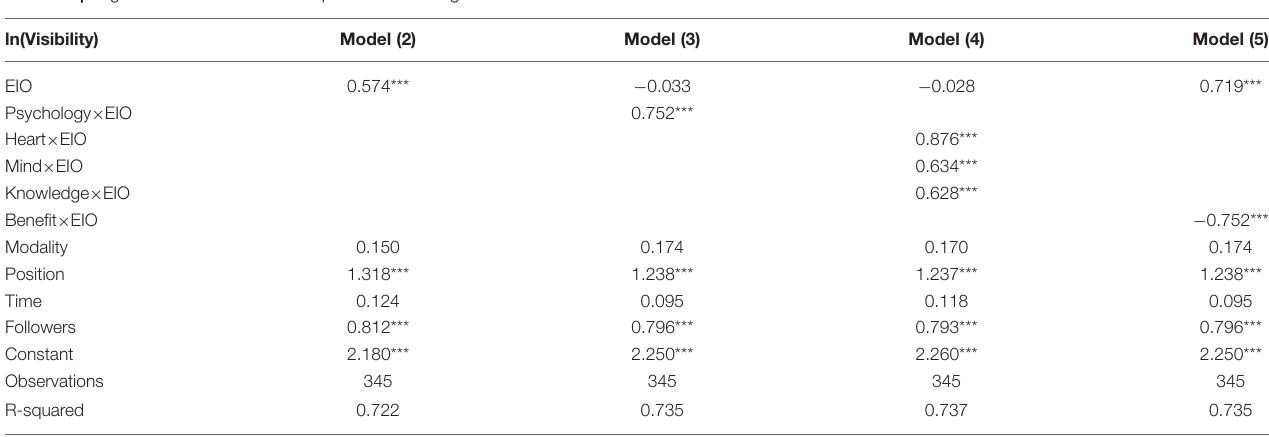
TABLE 6 | Regression results of content optimization